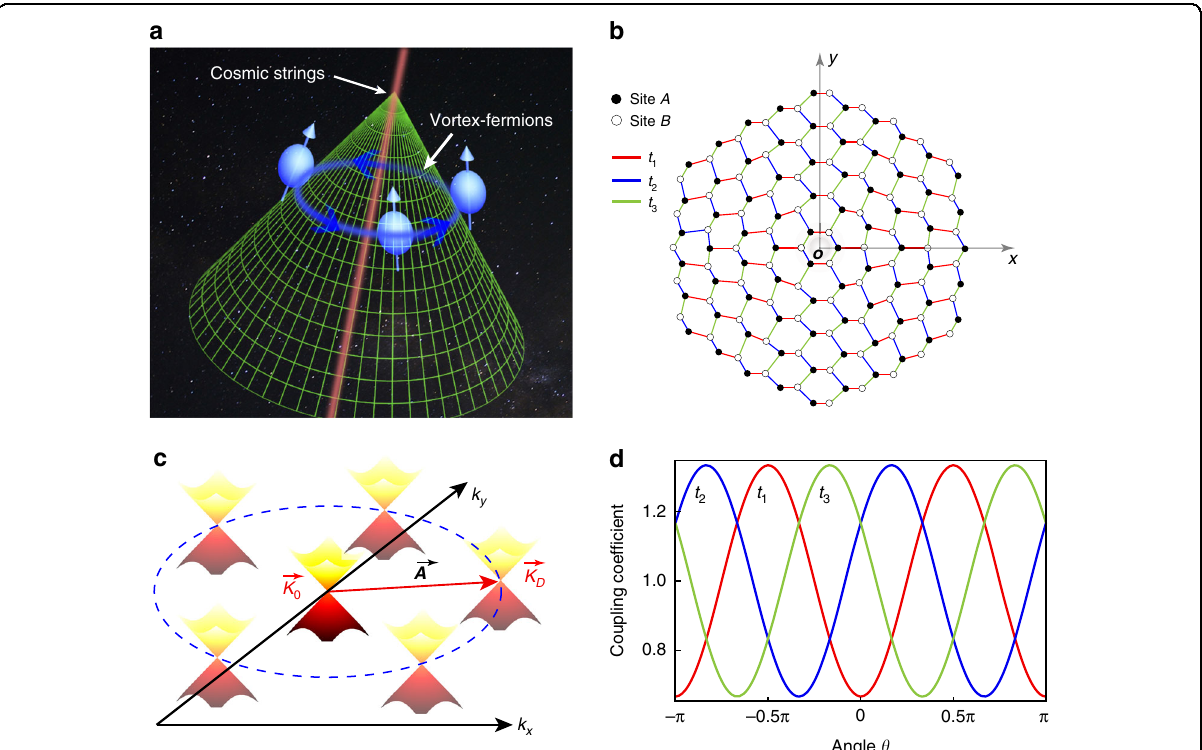
Fig. 1 The schematic of bound vortex fermions in the gauge fi eld of cosmic strings and the constructed photonic graphene with the position dependent coupling coef fi cients. a The depiction of a bound vortex of fermions in the gauge fi eld of the cosmic string. b The schematic of the deformed photonic graphene lattice with a position-dependent coef fi cient to emulate the cosmic string with a gauge fi eld. The symbol O is the origin center of the photonic graphene lattice where the defect was located. c The schematic of the movement of the Dirac cone ~ K D circling around ~ K 0 with the variation of the coupling coef fi cient; ~ A is the momentum shift of the Dirac cone in the deformed photonic graphene. d The designed coupling coef fi cient in a uniform photonic graphene to emulate a cosmic string with a gauge fi eld. In the actual waveguide system, such space dependent coef fi cients are realized by deforming photonic graphene just as shown in